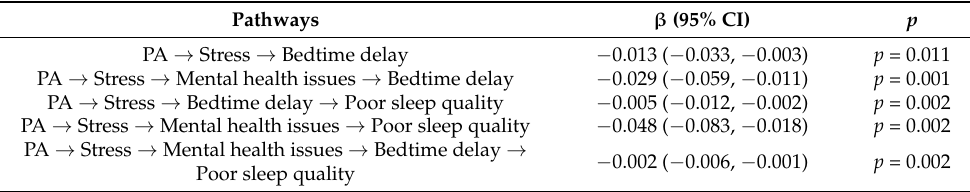
Table 4. Indirect pathways from PA to bedtime delay for TikTok and poor sleep